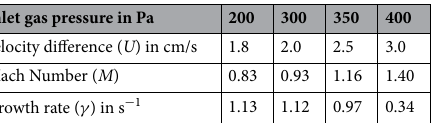
Table 1. Tabulated values of growth rates with Mach number estimated from the Eq.